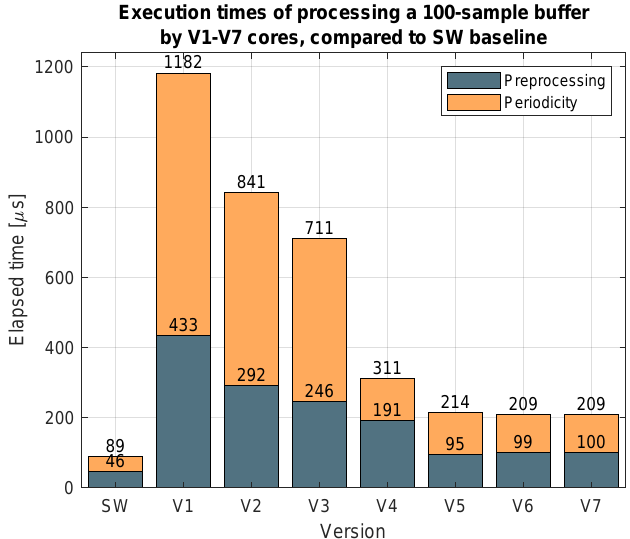
Figure 5. Execution times of seven IP core versions, compared to the software baseline, after process- ing a 100-sample